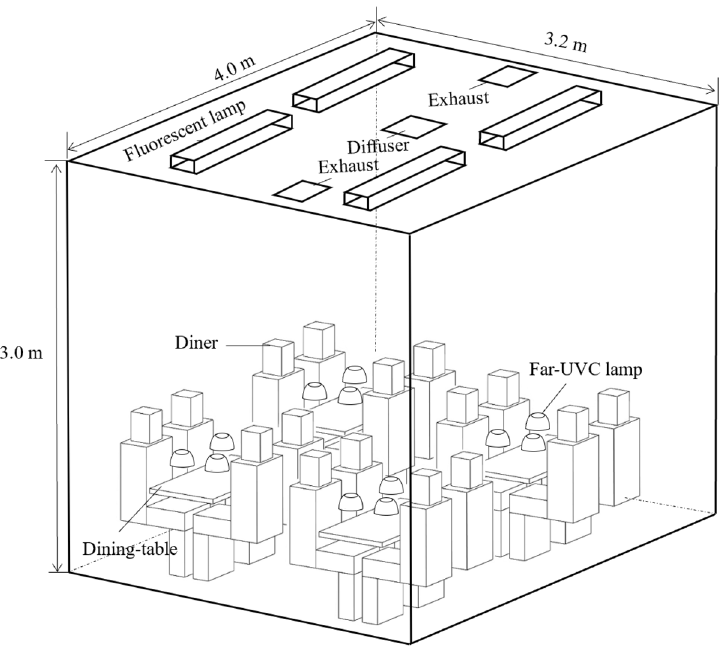
Figure 11. Geometric model of a dining hall using far-UVC lamps to disinfect dining tables.